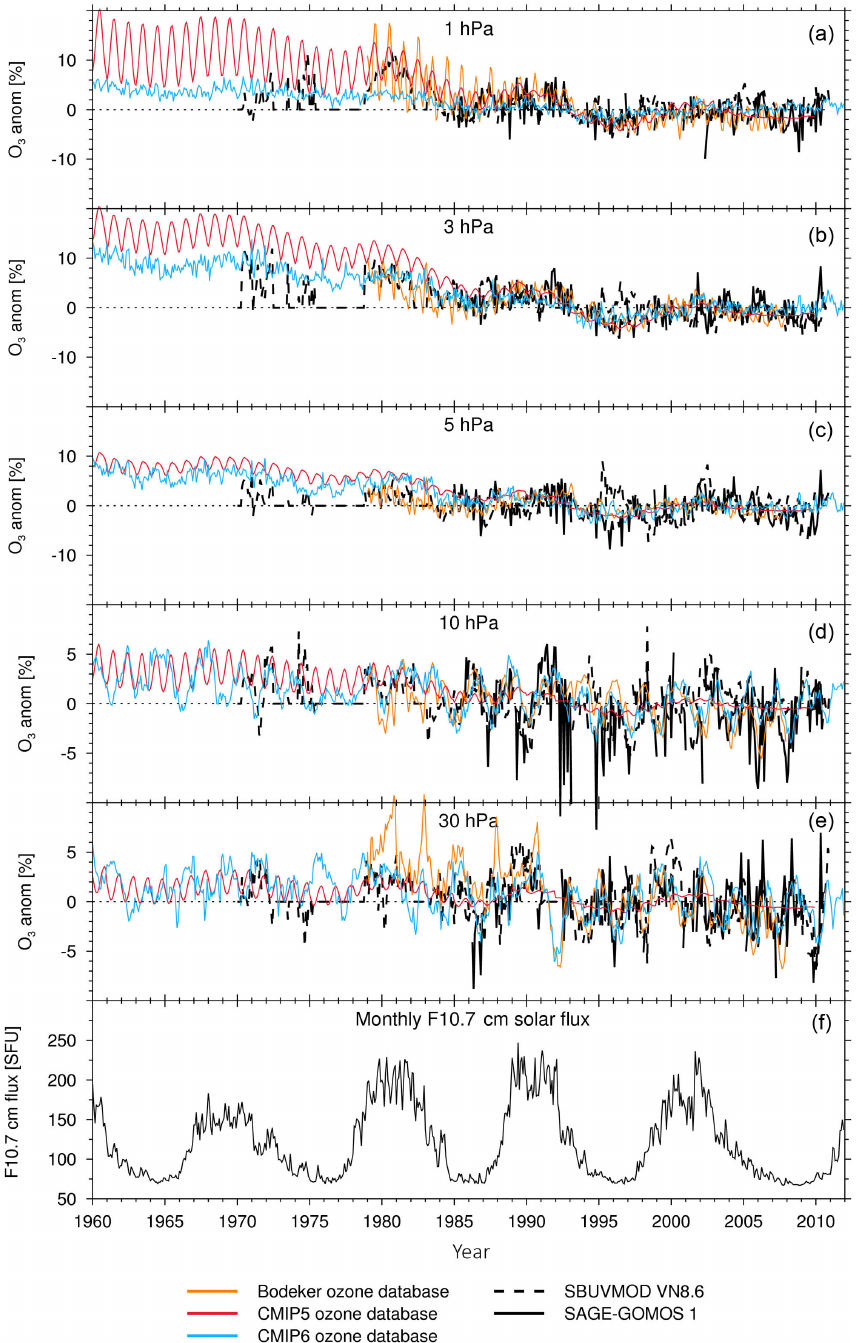
Figure 4. Time series of deseasonalized percent tropical (30 ◦ S–30 ◦ N) ozone anomalies from two satellite observation datasets (black) and the Bodeker (orange), CMIP5 (red) and CMIP6 (blue) ozone databases over the period 1960–2011 at (a) 1hPa, (b) 3hPa, (c) 5hPa, (d) 10hPa and (e) 30hPa. The lowest panel shows the F10.7cm solar flux for reference. Anomalies are shown relative to a baseline period